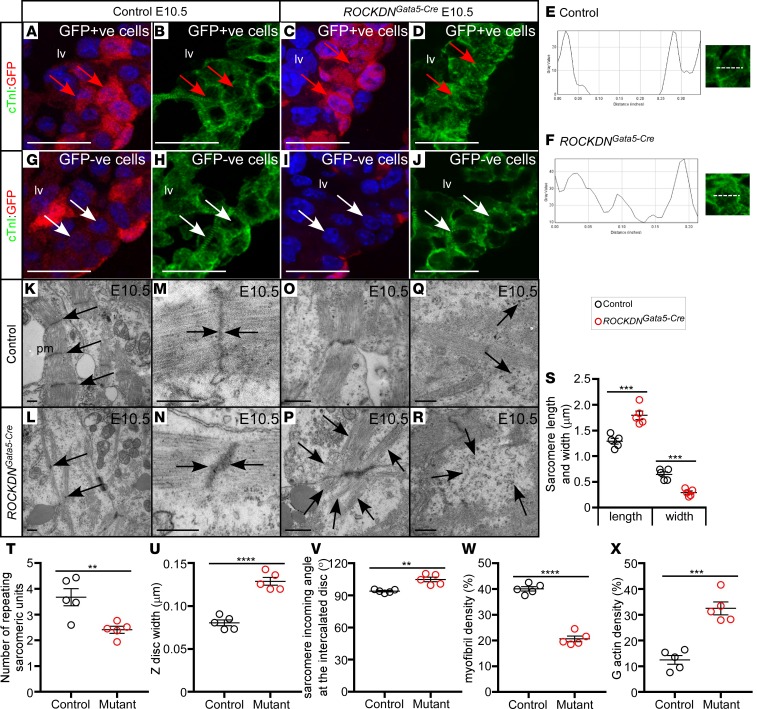
Destabilization of sarcomeres in ROCKDNGata5-Cre mutant cardiomyocytes at E10.5. (A–J) Transverse sections from E10.5 embryos were stained by immunofluorescence to identify all cardiomyocytes (cTnI staining, green) and Cre-activated cardiomyocytes/GFP+ cells (red staining).In Cre-activated cardiomyocytes of control embryos, cTnI was cortical (red arrows in B), confirmed by the 2 separate curves in the fluorescence intensity profile plot (E). In contrast, in Cre-activated cardiomyocytes of ROCKDNGata5-Cre mutants, cTnI staining was disrupted, as it was diffuse throughout the cell (red arrows in D), confirmed by the continuous line in the fluorescence intensity profile plot (F). The cTnI staining in GFP negative cardiomyocytes in control and ROCKDNGata5-Cre mutants was identical (white arrows in G–J). n=6 for each genotype. (K–R) Representative TEM imaging of myofibrils at E10.5. In controls, the sarcomeres generally align in close proximity to the plasma membrane and are highly organized (arrows in K). In ROCKDNGata5-Cre cardiomyocytes, the myofibrils are located throughout the cells and show sarcomere collapse (arrows in L). The average width of the Z discs throughout the sarcomeres was significantly increased in ROCKDNGata5-Cre cardiomyocytes compared with controls (M, N, and U). Myofibril discontinuity was present at cellular junctions in ROCKDNGata5-Cre as the myofibrils approached the intercalated discs at more varied wider angles (arrows in P and V) but not seen in controls (O). Areas of G-actin accumulation were detected in ROCKDNGata5-Cre cardiomyocytes (R) more frequently that in control hearts (Q) giving a significant increase in G-actin density (X). (S) There was a significant increase in sarcomere length and decrease in sarcomere width in ROCKDNGata5-Cre mutants compared with sarcomeres in control hearts. (T) The number of repeating sarcomeric units, per field of view in comparative regions, was significantly reduced in ROCKDNGata5-Cre cardiomyocytes. (W) As a consequence of the abnormal sarcomeric structure, in ROCKDNGata5-Cre cardiomyocytes, there was significantly reduced myofibril density per field of view. (X) The percent area containing G-actin, per field of view, showed a significant increase in ROCKDNGata5-Cre cardiomyocytes. n = 5 for each genotype. lv, left ventricle; pm, plasma membrane. Data are presented as mean ± SEM. **P < 0.01, ***P < 0.001, ****P < 0.0001 by unpaired t test. Scale bars: 50 μm (A–D and G–J) and 500 nm (K–R).